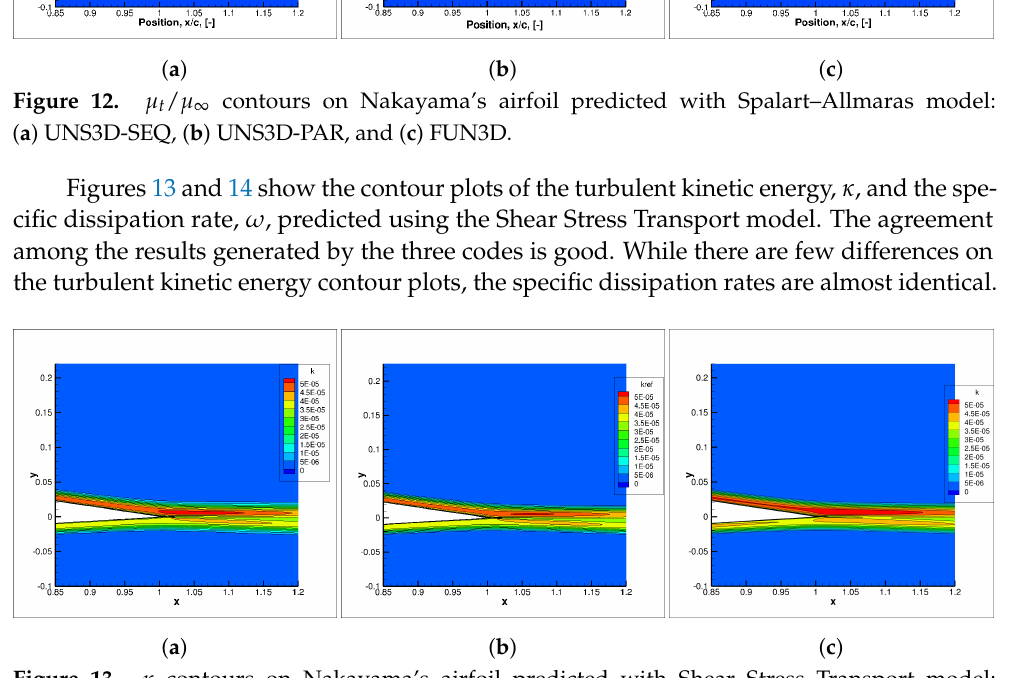
Figure 13. κ contours on Nakayama’s airfoil predicted with Shear Stress Transport model: ( a ) UNS3D-SEQ, ( b ) UNS3D-PAR, and ( c )